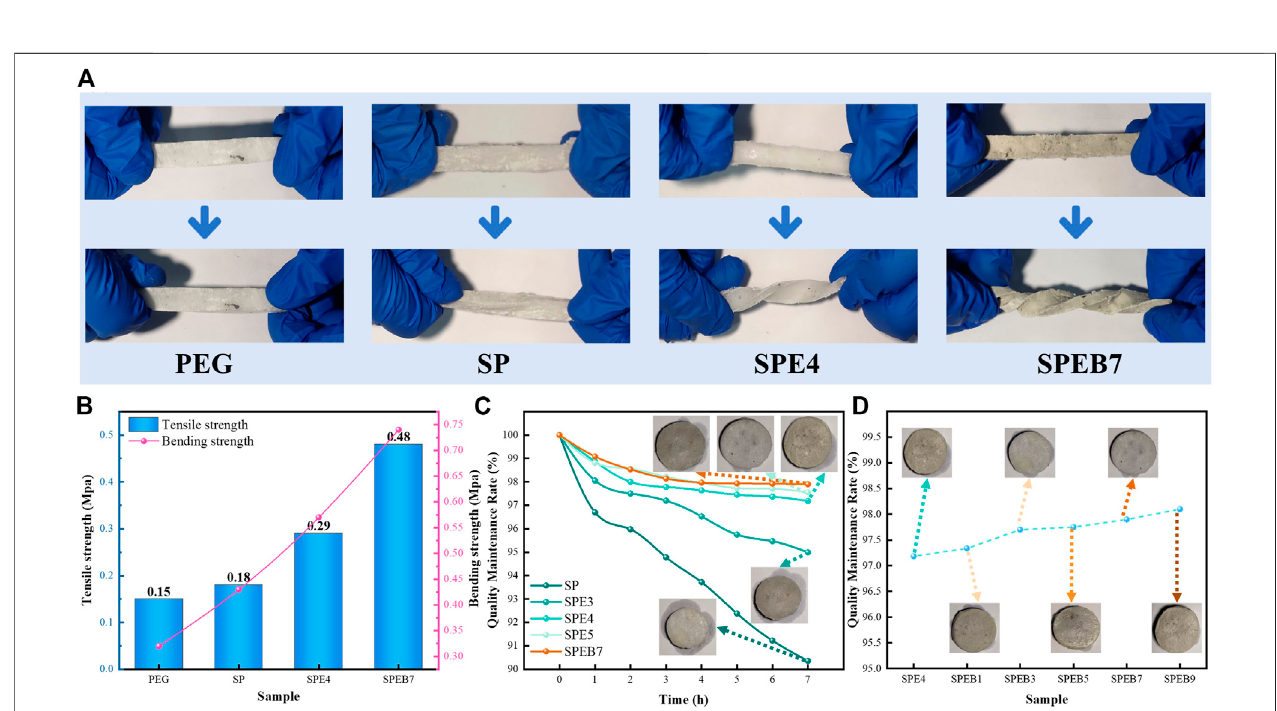
FIGURE 5 | (A) Twist test results of the different samples. (B) Tensile strength and bending strength curves of the different samples. (C) The quality maintenance rate curves of the different samples. (D) The quality maintenance rate curves of the different samples with boron nitride (BN).